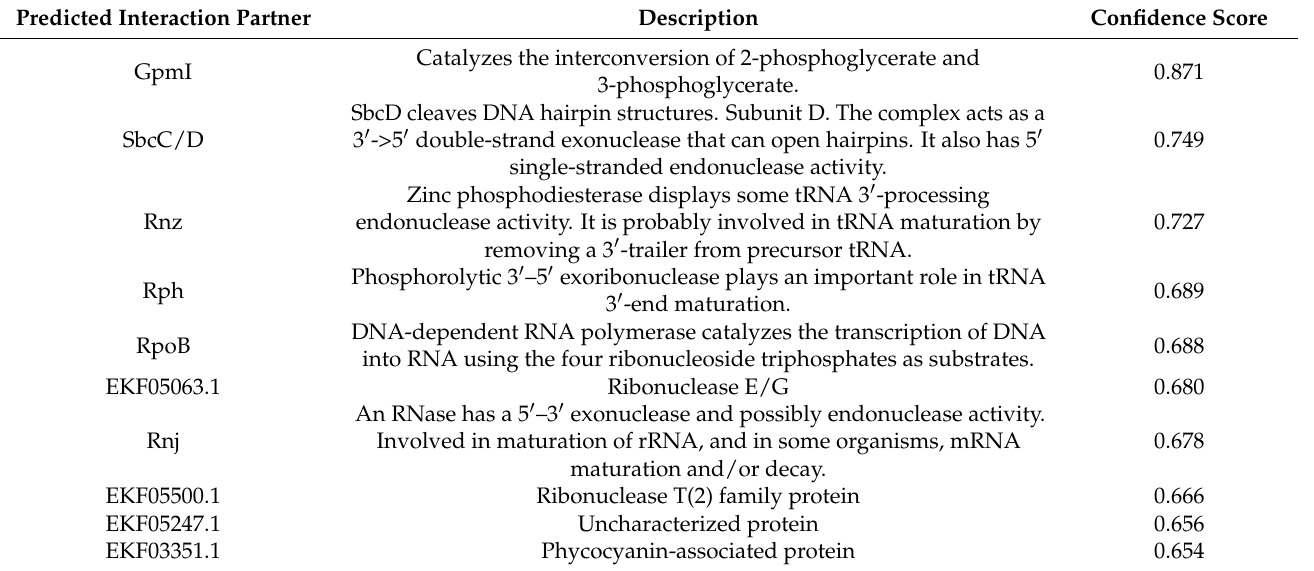
Figure 6. Protein–protein interaction network for Fd PsoR. A protein–protein interaction network was generated using STRING [42]. The PsoR protein sequence (GenBank ID: EKE97789.1) from F. diplosiphon was used as a query. Edges represent functional associations, and differently colored lines represent different types of interactions: green line, neighborhood of genes; blue line, co-occurrence across species; purple line, experimental evidence; yellow-green line, text mining; light blue line, database documentation; black line, co-expression data. Table 4. Proteins predicted to interact with Fd PsoR from Fremyella diplosiphon using the STRING program.